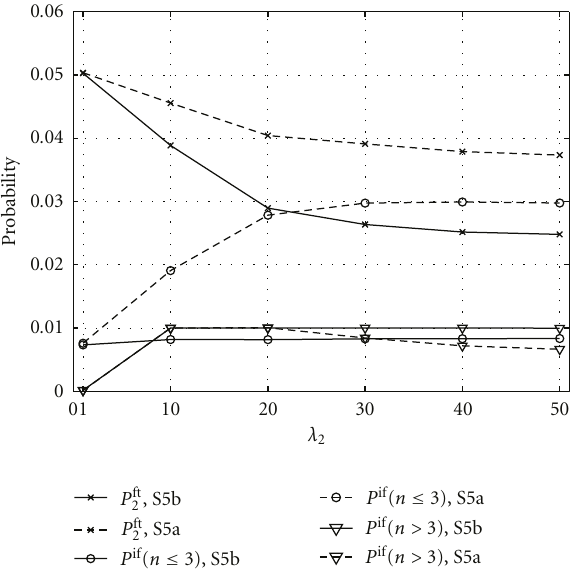
Figure 8: P ft 2 and interference with λ 2 in S5a and